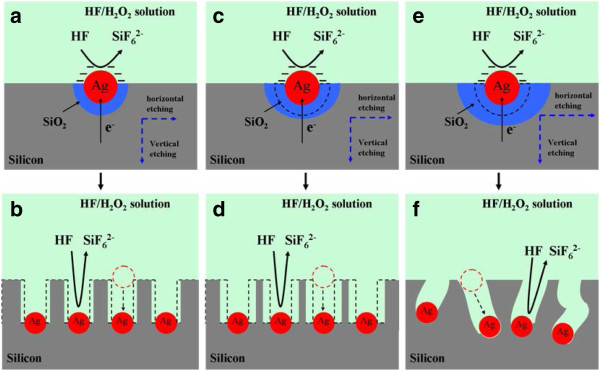
Schematic diagram of Ag nanoparticle-assisted etching with the increase of H2O2 concentration: (a, b) 10%, (c, d) 20%, and (e, f) 30%.